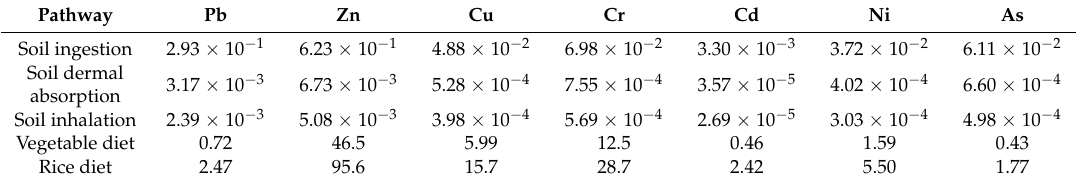
Table 6. Daily intake from heavy metals via various exposure pathways ( µ